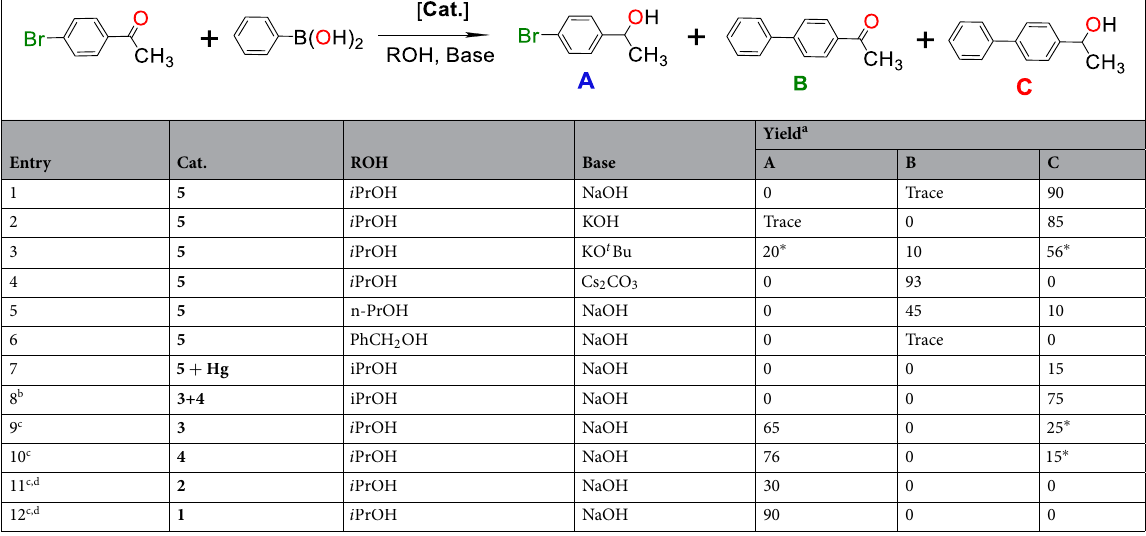
Table 1. Tandem Suzuki coupling/transfer hydrogenation of 4-bromoacetophenone and phenylboronic acid. Reaction condition: Catalyst/4-bromoacetophenone/ PhB(OH) 2 / base 1.0 mg/0.1 mmol/0.14 mmol/0.7 mmol,